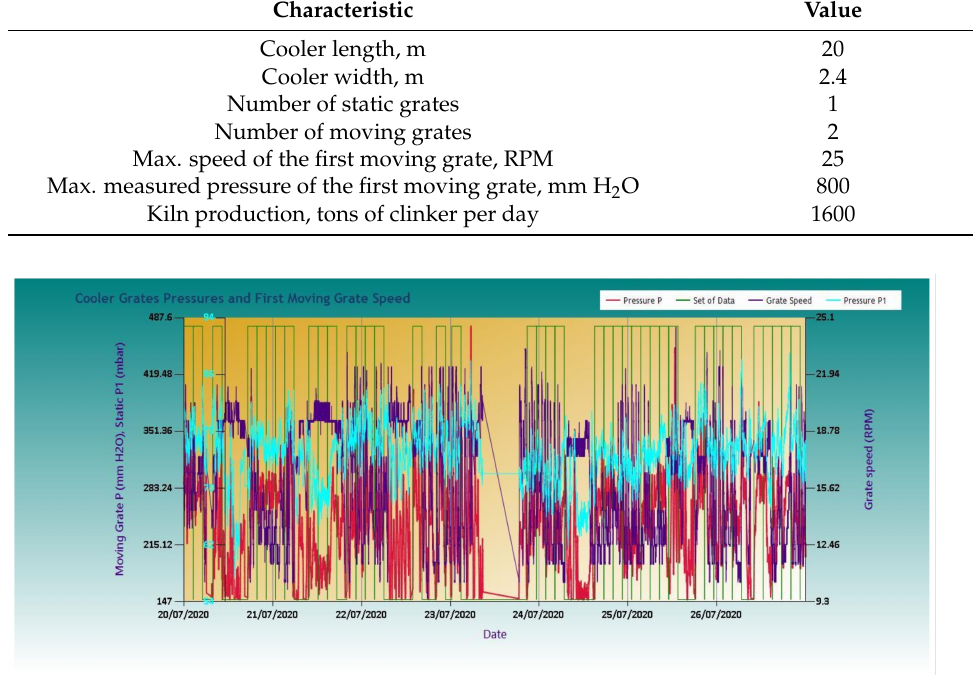
Figure 4. Typical data sets extracted from the SQL